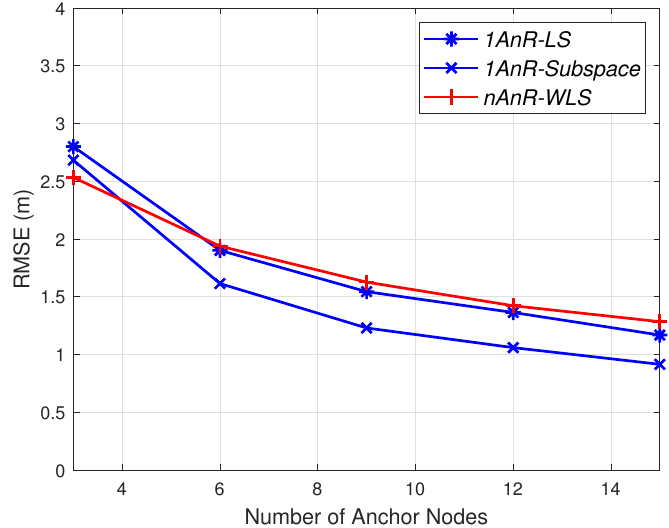
= 0.3 dB, σ m = 5 degrees, with the master anchor at the centre of the i i